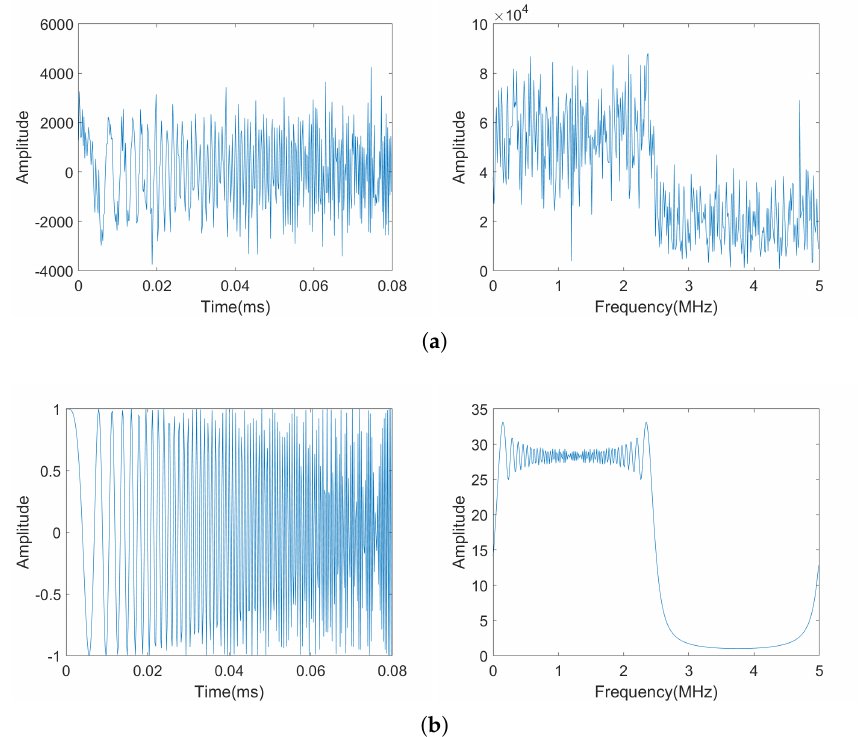
Figure 14. Time-domain and frequency-domain plots of the intercepted direct wave signal and reconstructed reference signal. ( a ) Intercepted direct wave signal; ( b ) Reconstructed reference signal